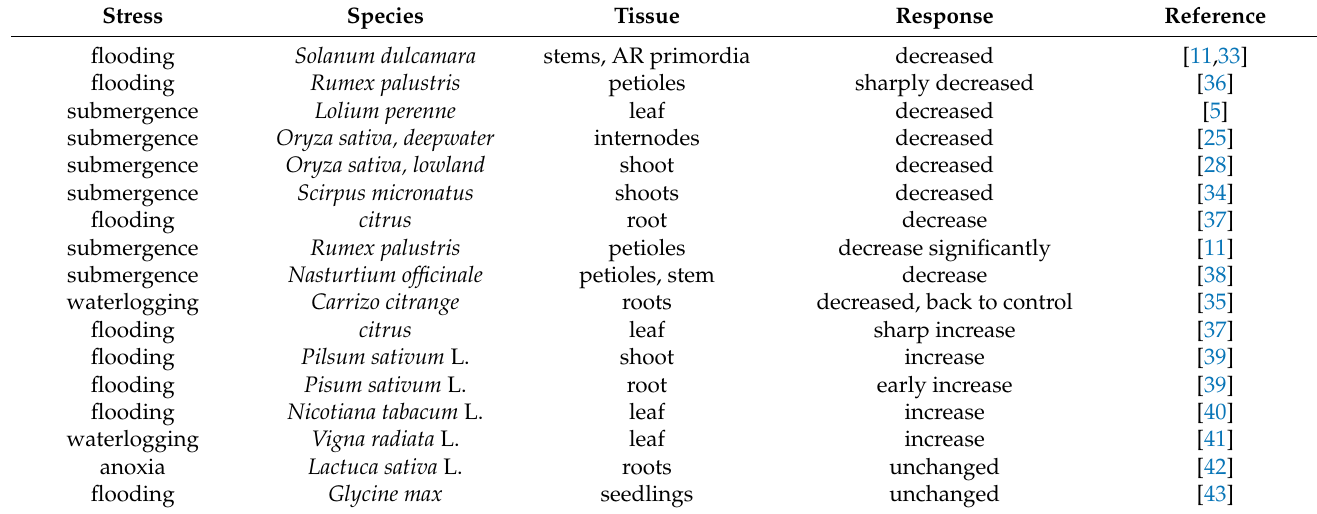
Table 1. Changes of ABA concentration affected by flooding stress in different plant